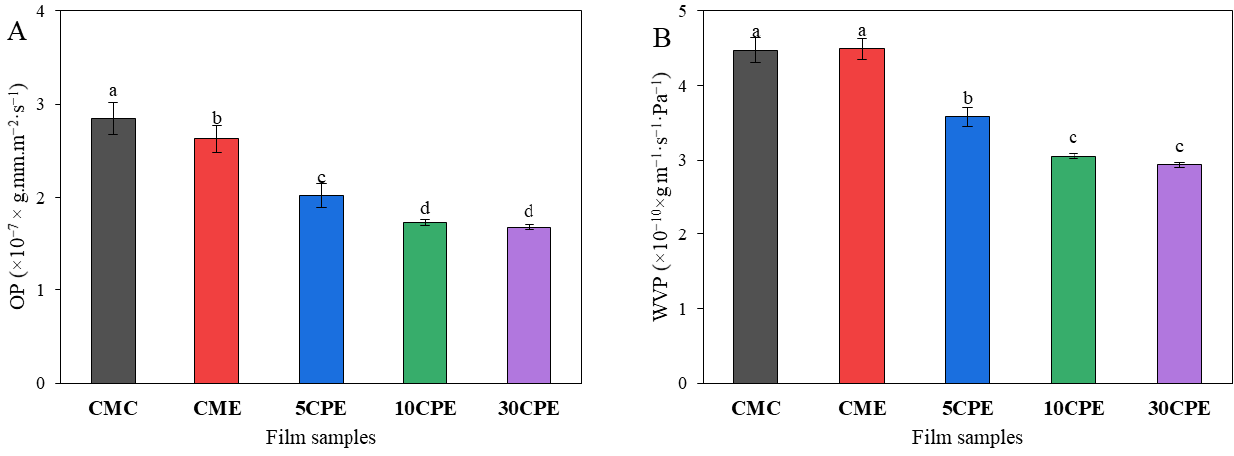
Figure 6. Oxygen ( A ) and water vapor permeability ( B ) of films. Values represent mean ± SD ( n = 3), and different superscripts denote significant differences (DMRT, p < 0.05).